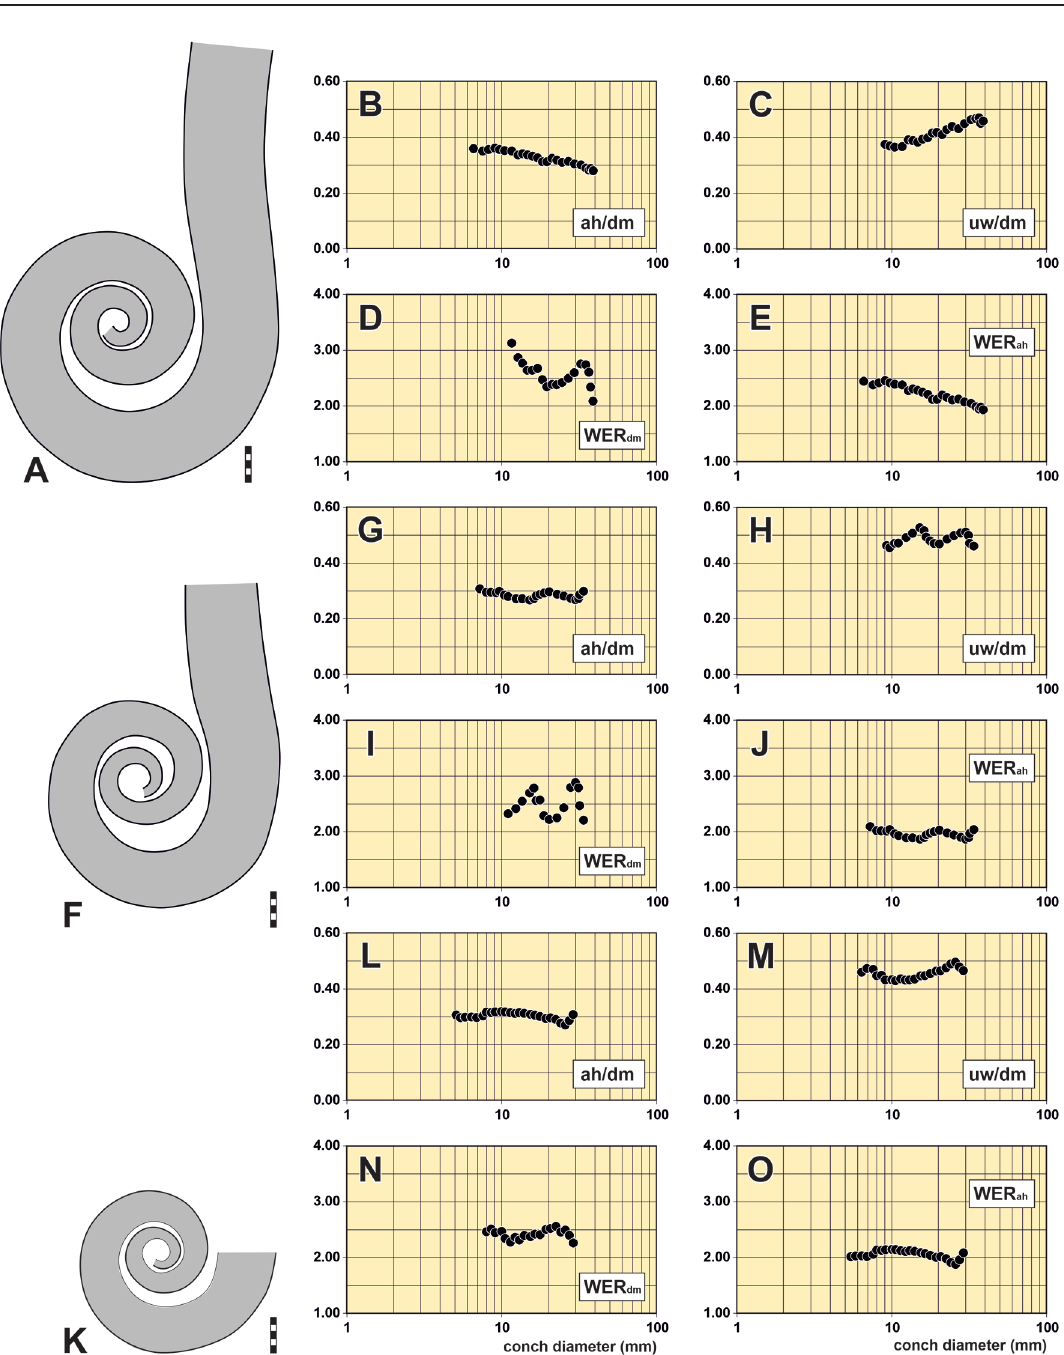
Fig. 39. Lituites perfectus Wahlenberg, 1818. A . Outline of coiled conch part of neotype MB.C.30544. B–E . Conch proportions and coiling rates of neotype MB.C.30544. F . Outline of coiled conch part of specimen MB.C.30542. G–J . Conch proportions and coiling rates of specimen MB.C.30542. K . Outline of coiled conch part of specimen MB.C.11646. L–O . Conch proportions and coiling rates of specimen MB.C.11646. Scale bar units = 1